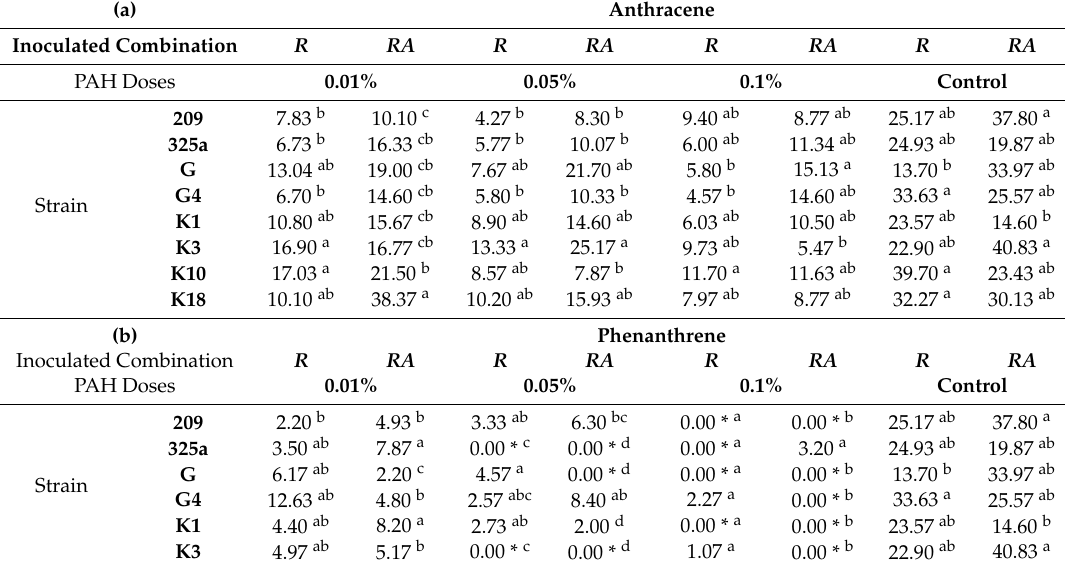
Table 3. The dry weight of clover (mg) depending on the dose of contamination with each PAH: ( a ) anthracene; ( b ) phenanthrene; ( c ) pyrene. The inoculated combination is given by R (inoculated with Rhizobium leguminosarum only) or RA (co-inoculated with Rhizobium leguminosarum and Azospirillum brasilense strains). Control samples were grown without PAH. The di ff erent letters (a–d) in the columns indicate significant results (Fisher’s LSD test, P ≤ 0.05, n = 3). * indicates that in this combination, the average dry weight of the plants ( n = 3) was